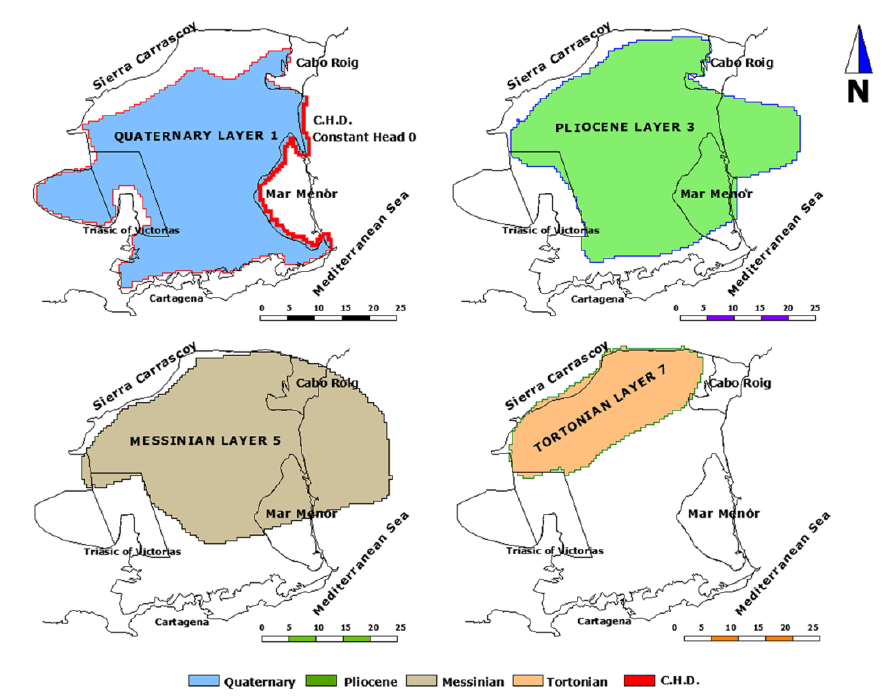
Figure 4. The various aquifer layers in the flow model.